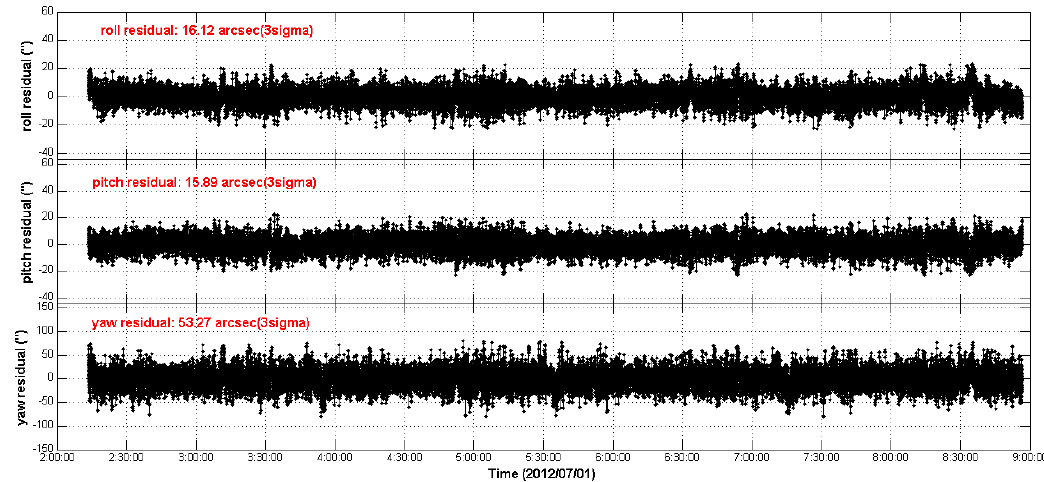
Figure 11. The relative Euler angle residual streams as time series (with LFE compensation).